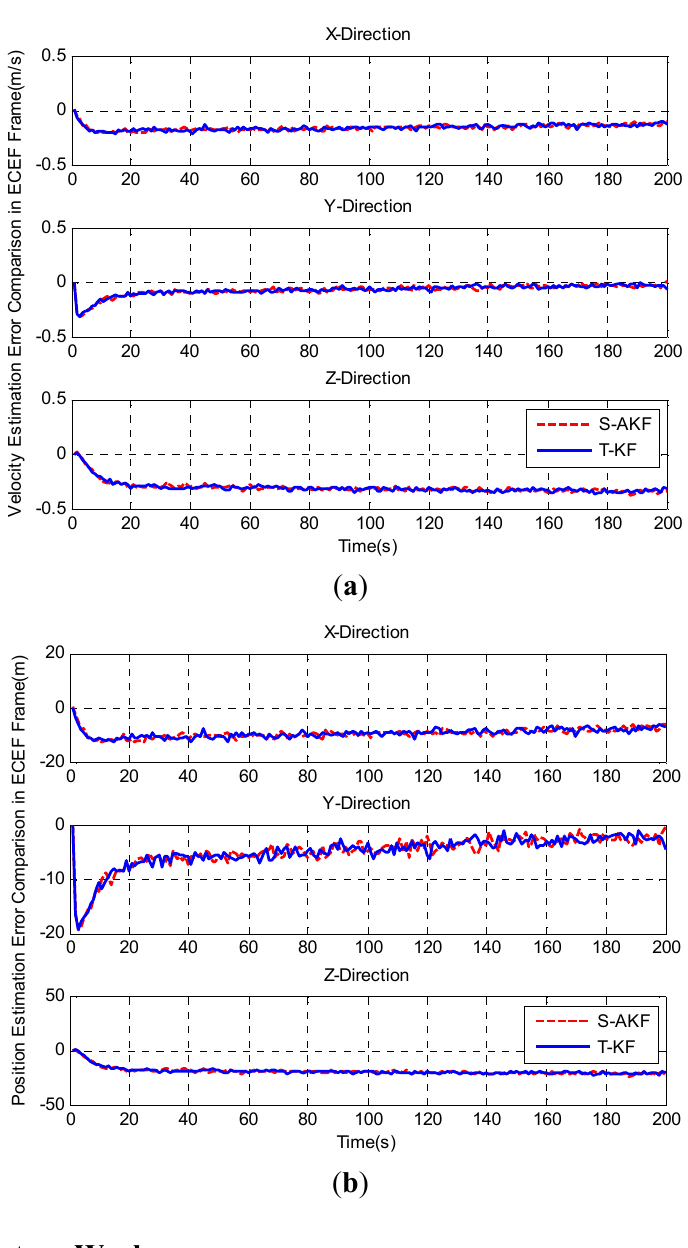
Figure 12. ( a ) Velocity estimation errors of S-AKF and T-KF in ECEF frame; ( b ) Velocity estimation errors of S-AKF and T-KF in ECEF